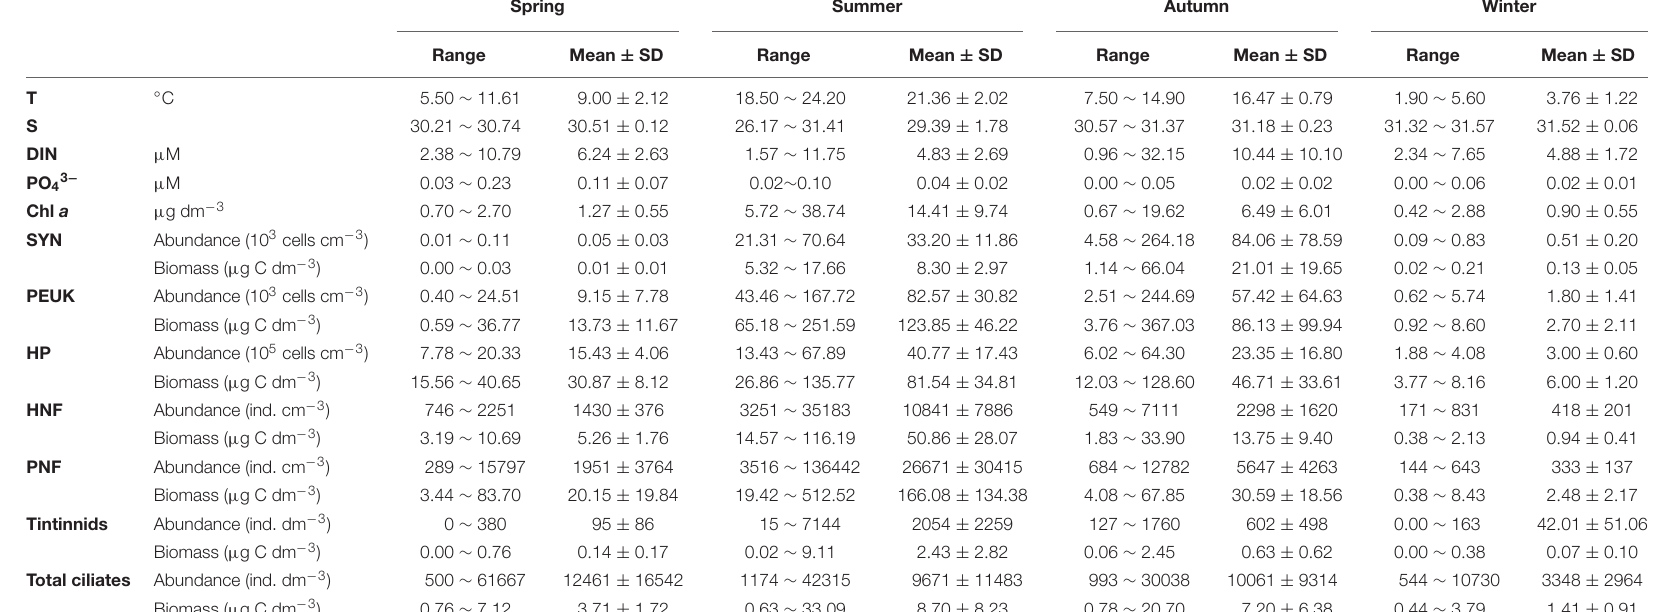
TABLE 1 | Maximum, minimum, and average values of temperature (T), salinity (S), Chlorophyll a concentration (Chl a ), nutrient concentrations, microbial food web component abundances and biomasses in Sanggou Bay at four consecutive seasons. Spring Summer Autumn